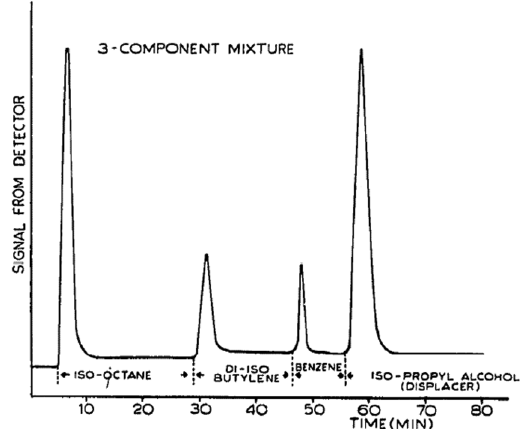
Figure 1. Signal from a thermocouple as a function of time. The temperature spike occurs as the resident liquid is replaced by iso-propyl alcohol 4